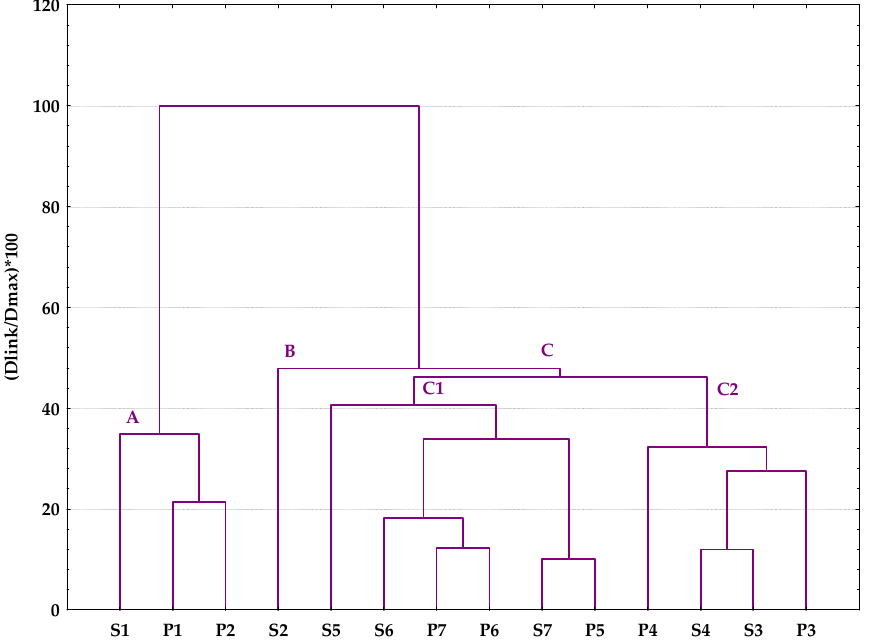
Figure 6. Dendrogram obtained by the cluster analysis for all 14 plum spirits based on the contents of 23 examined volatile components.